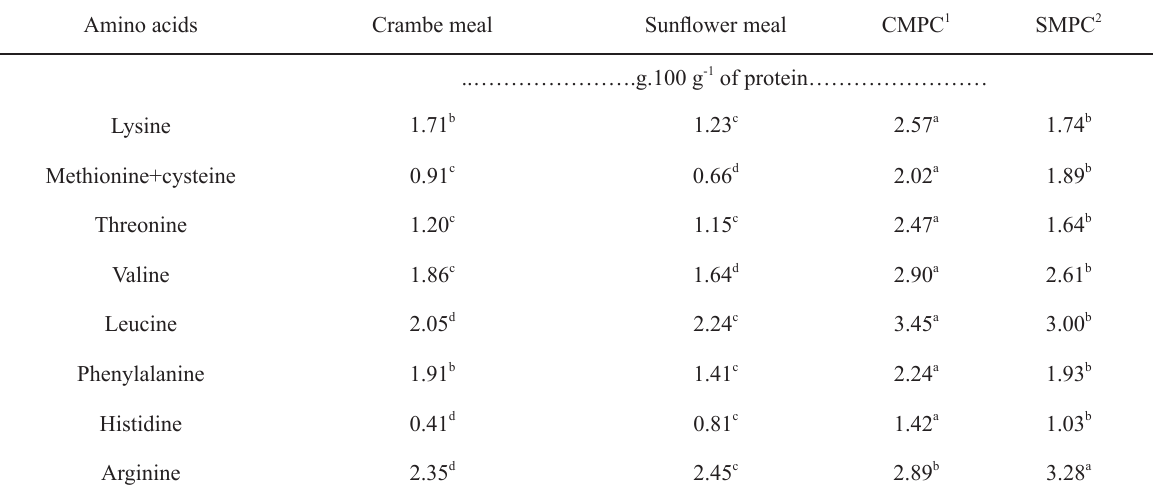
Amino acids levels (g 100 g -1 ) in the crambe and sunflower protein concentrates and meals. Amino acids